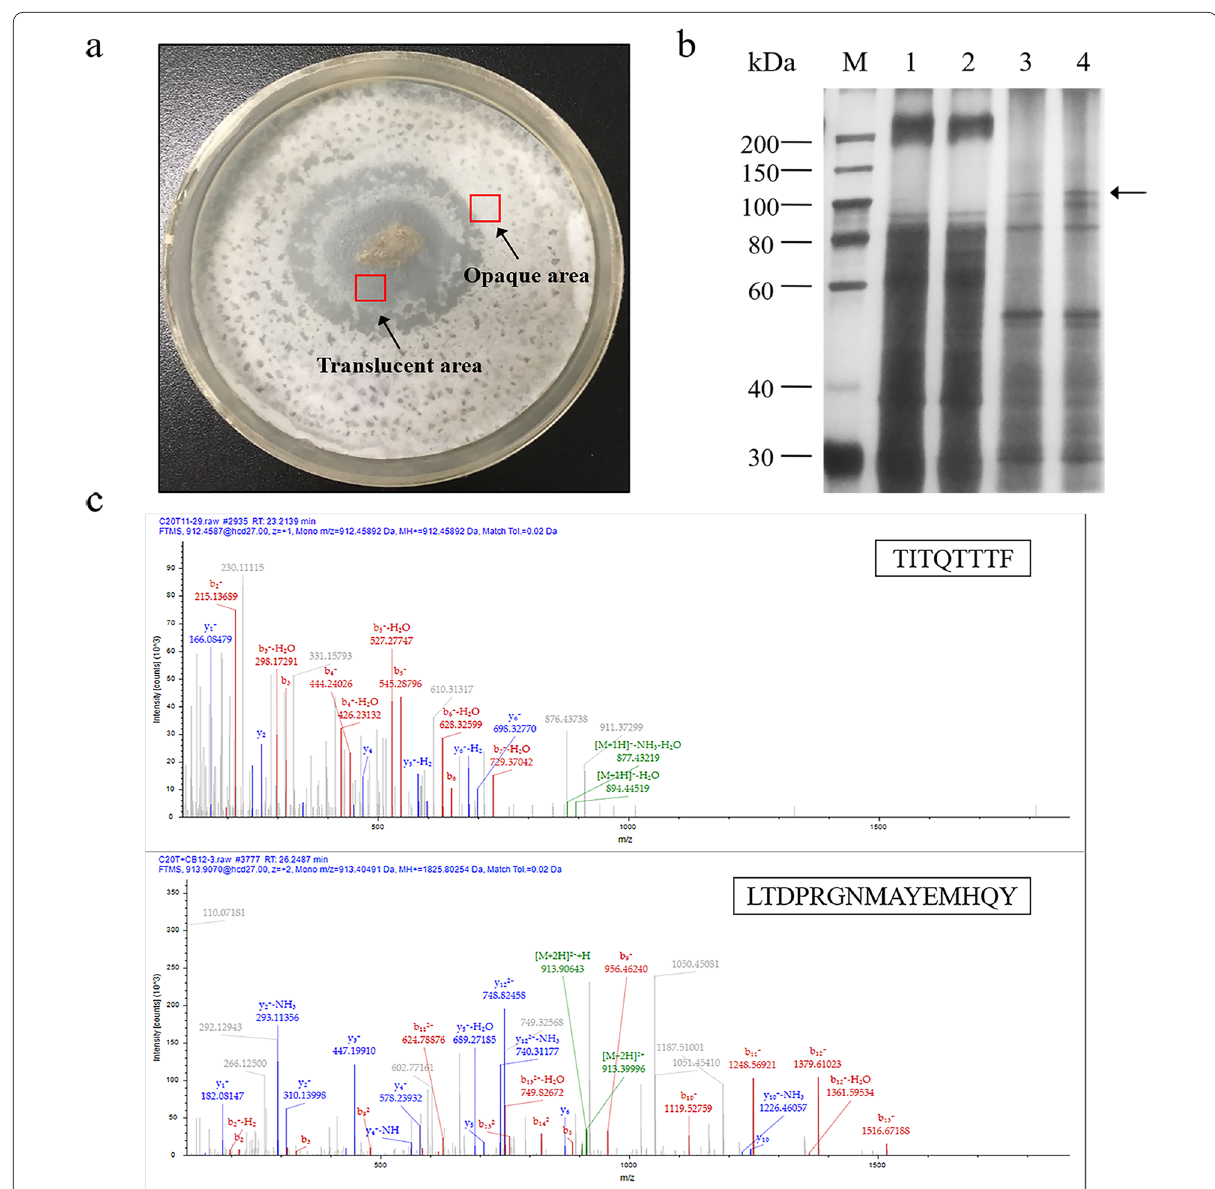
Fig. 1 Isolation of ArCel5. a The decrystallization phenomenon on filter paper agar plate caused by the growth of cellulose-gelatinizing fungus Arthrobotrys sp.CX1. b The different secretary proteins between opaque area and the transparent area were assessed by SDS-PAGE. Lanes 1–2 showed the total proteins of the opaque area in the filter paper sample. Lanes 3–4 showed the total proteins of the transparent area in the filter paper sample. The arrow indicates a differential protein band found only in the transparent region. c LC–MS/MS fragment ion spectra of the peptides in the arrow area. The peptide TITQTTTF and LTDPRGNMAYEMHQY were distinguished and